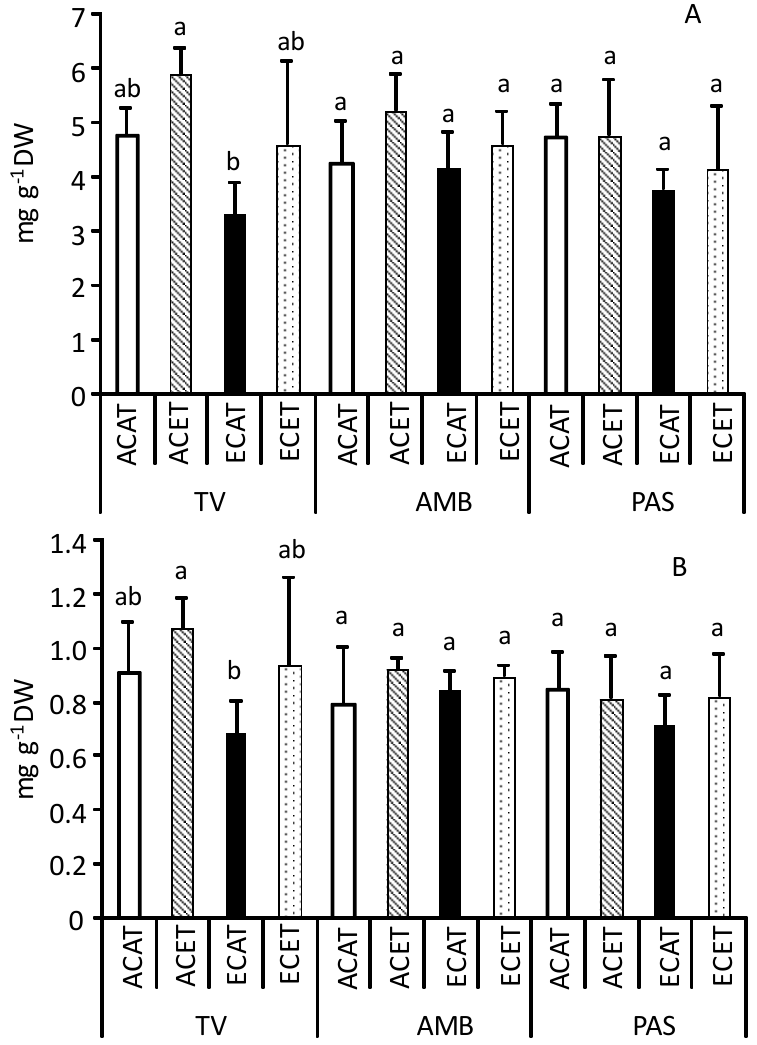
Figure 1. Concentrations of total chlorophylls (a + b) (mg g − 1 DW) ( A ) and total carotenoids (mg g − 1 DW) ( B ) in leaves of grapevine Tinto Velasco (TV), Ambrosina (AMB), and Pasera (PAS) grown at (1) ambient (~400 µ mol mol − 1 ) CO 2 concentration (AC) and ambient temperature (AT) (ACAT); (2) AC and elevated (T + 4 ◦ C, ET) temperature (ACET); (3) elevated CO 2 (700 µ mol mol − 1 , EC) and AT (ECAT), and (4) EC and ET (ECET). Bars represent means ± S.E. (n = 3–6). Within each graph and grapevine variety, bars topped by same letter indicate that values do not differ significantly ( p > 0.05). DW = dry weight.